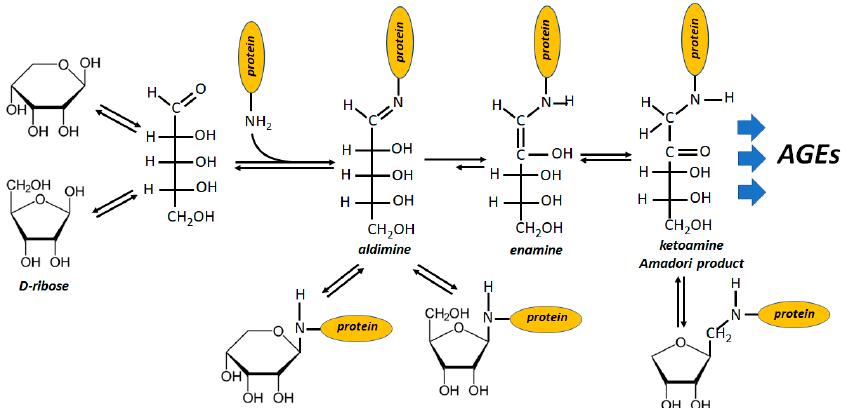
Figure 3. Schematic representation of AGEs generation upon protein glycation induced by D-ribose. The same reactions progression may apply to R5P, except for the pyranosidic structure of the sugar phosphate, for the cyclic N-substituted-1-C- ribopyranoside and then for the cyclic N-substituted-1-C-ribulofuranoside.